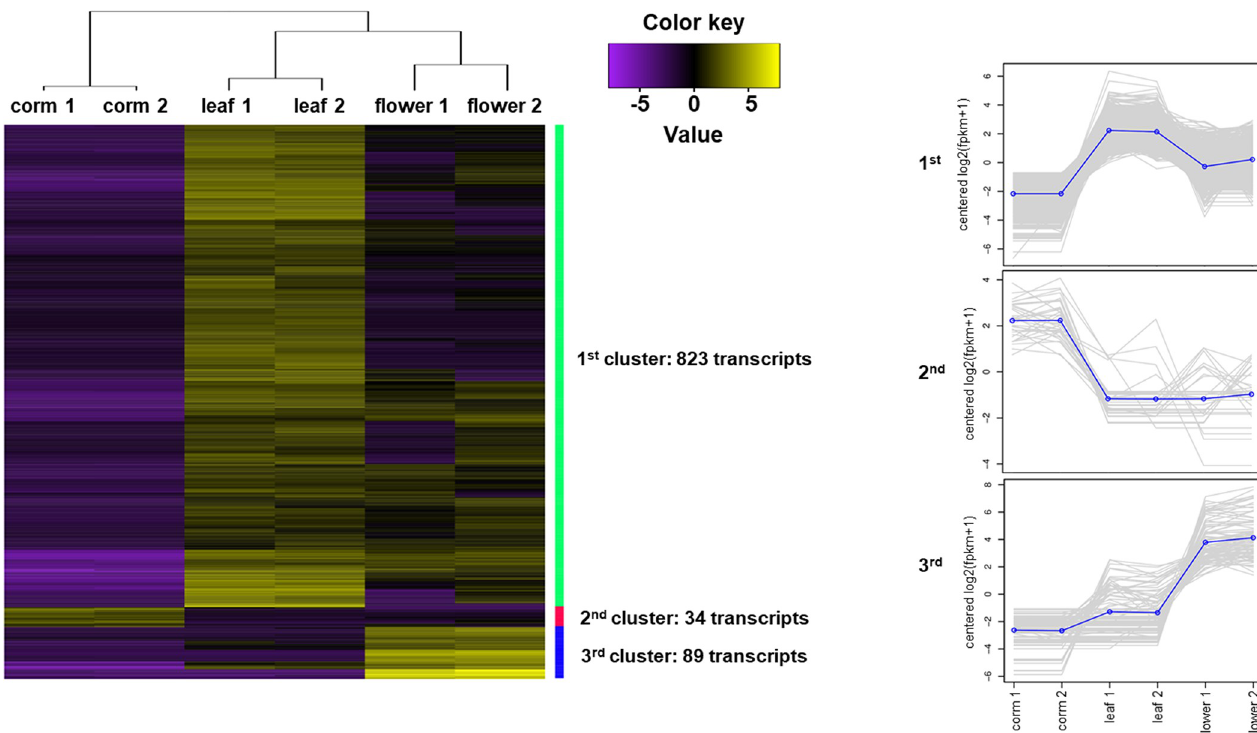
Fig 3. Heatmap of the differentially expressed transcripts between the tuber, leaf and flower tissues of H . hemerocallidea . The heatmap was generated with a p-value of 0.05 and a one-fold change cut-off for the false discovery rate of the differential expression analysis performed with edgeR. The 1 st cluster of 823 transcripts was found to be upregulated in the leaf tissue with a mean log2(fpkm+1) of 2.2. A similar mean is exhibited by the 34 transcripts upregulated in the corm tissue (2 nd cluster). However, the mean log2(fpkm+1) of the upregulated transcripts in the flower tissue (3 rd cluster) is double that of the tuber and leaf upregulated transcripts. Line plots depict the expression levels of transcripts for each of the three clusters.